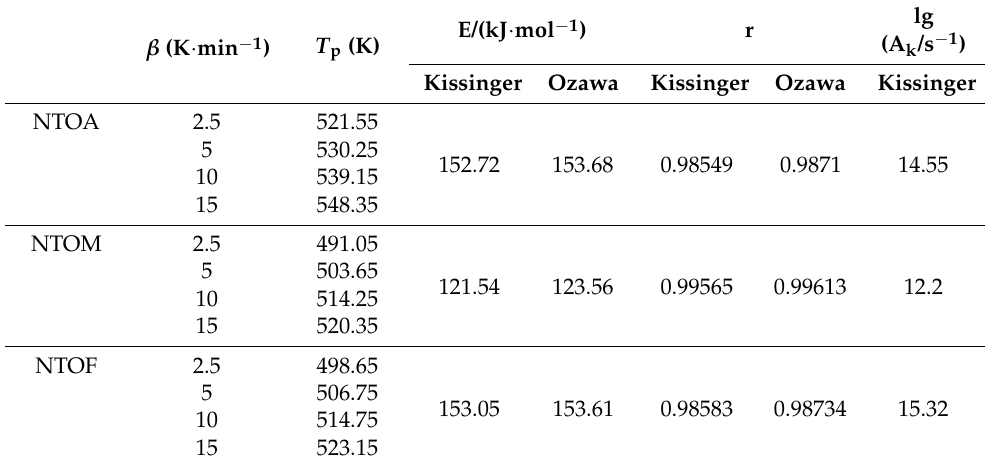
Table 1. Kinetic parameters and enthalpies of thermal decomposition of NTOA, NTOM and